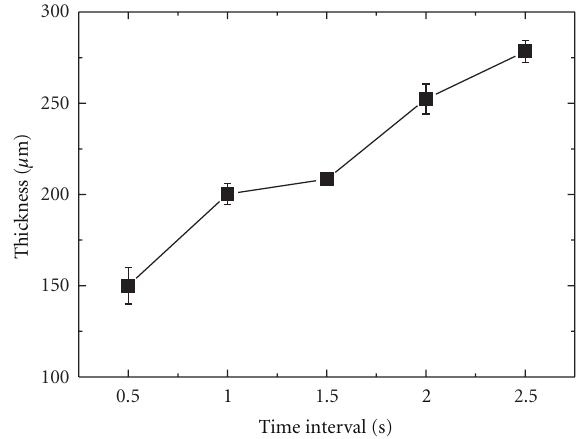
Figure 3: Thickness variation of ribbon-type Si wafers depending on the time interval at the range of 0.5–2.5 sec at the constant substrate temperature of 1000 ◦ C, moving velocity of substrates of 485 cm/min, and blowing rate of Ar gas of 0.8Nm 3 /h.